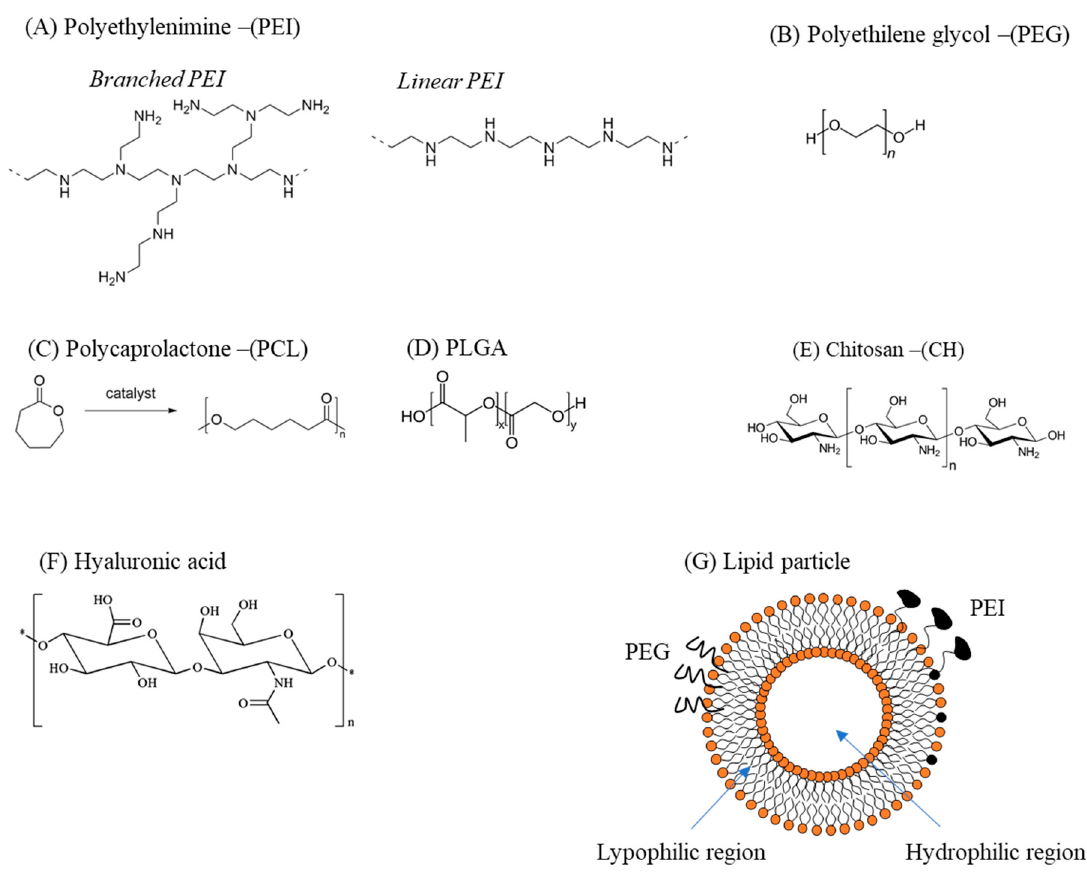
Figure 5. Structure of polymer- and lipid-based delivery materials, ( A ) polyethylenimine (PEI), ( B ) polyethylene glycol (PEG), ( C ) polycaprolactone (PCL), ( D ) poly(lactic- co -glycolic acid) (PLGA), ( E ) chitosan (CH), ( F ) hyaluronic acid (HA), and ( G ) lipid